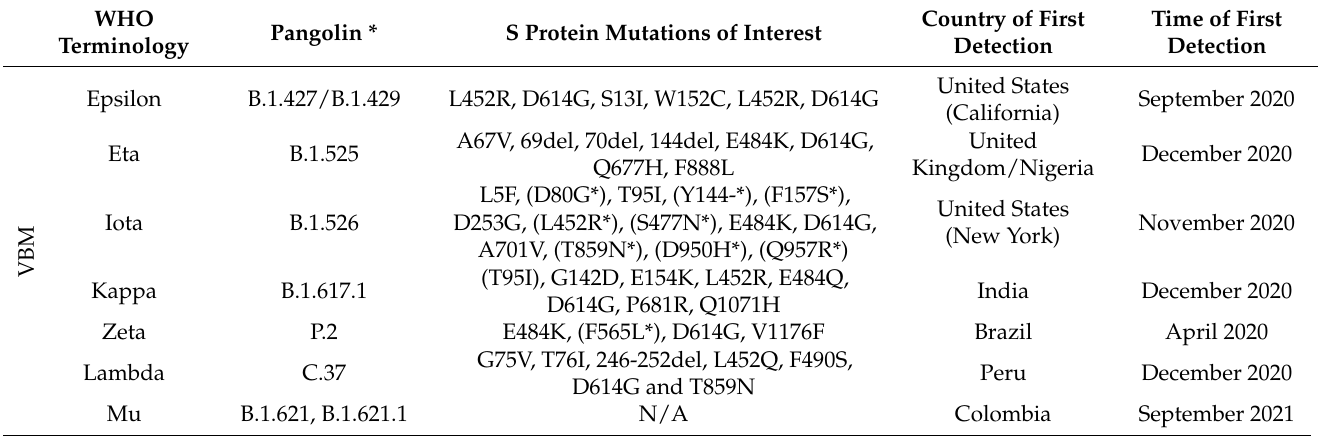
Table 1. SARS-CoV-2 Variants Being Monitored (VBM) and Variants of Concern (VOC)